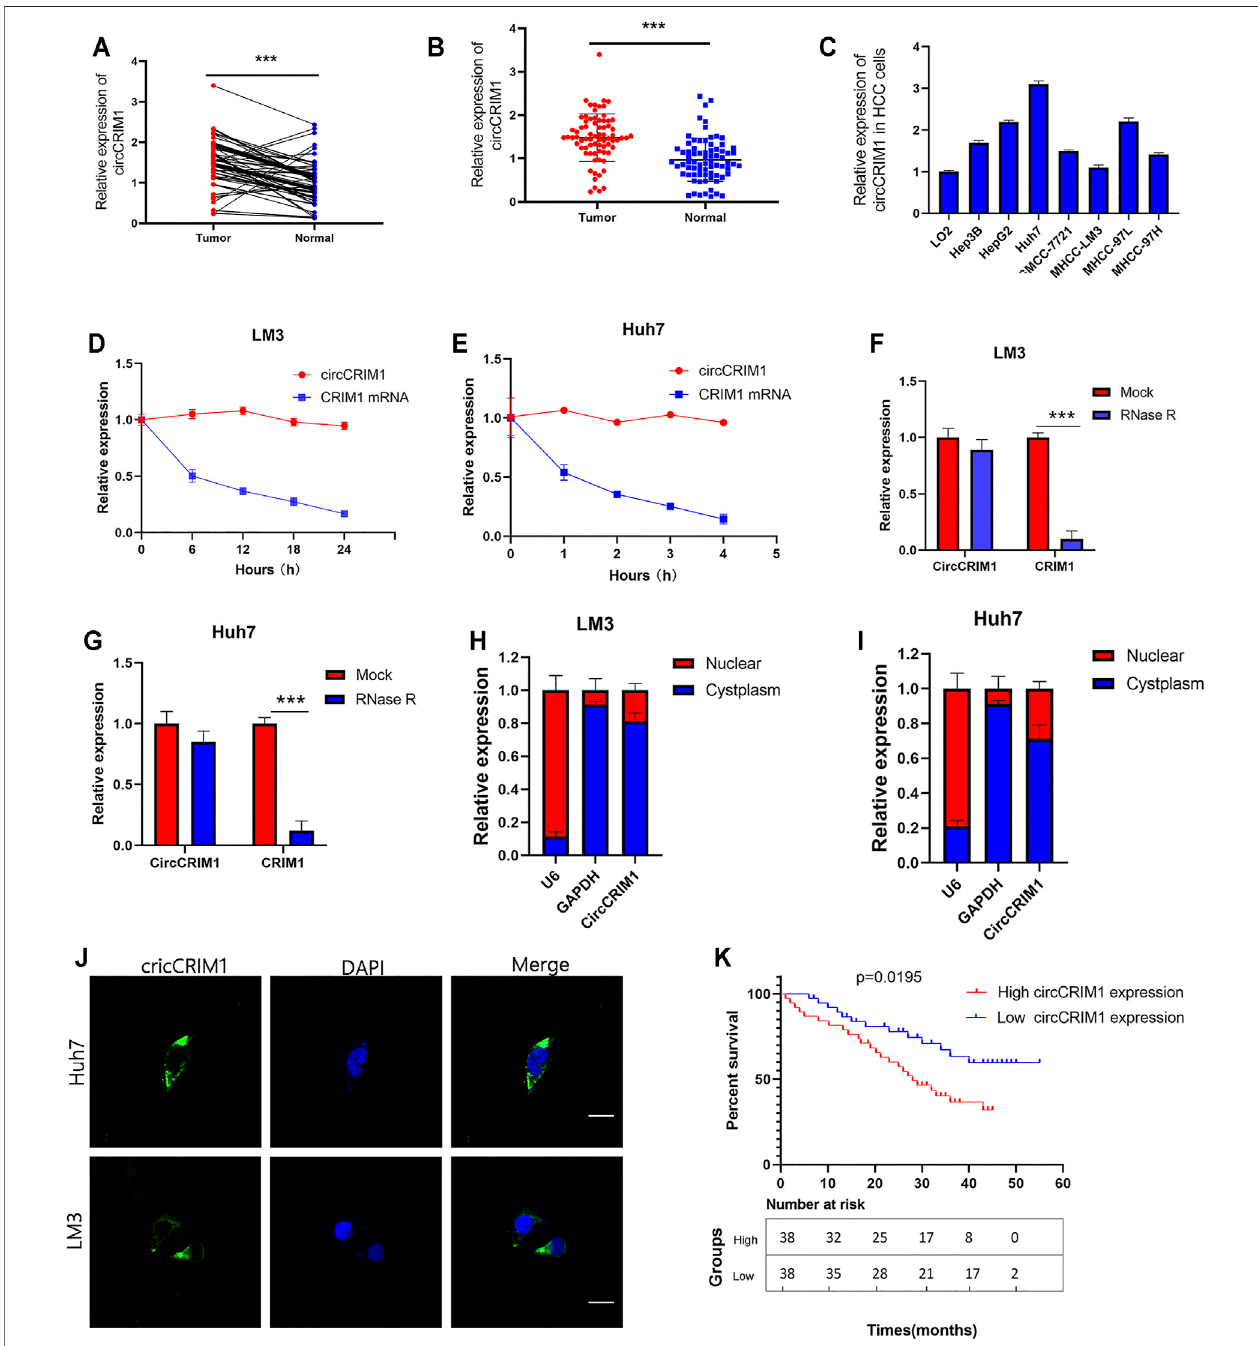
FIGURE 1 | CircCRIM1 is upregulated in HCC cell lines and tissues. (A,B) Relative circCRIM1 expression in HCC tissues (tumor) and adjacent non-tumor tissues (adjacent) was detected by qRT-PCR ( n (cid:2) 76). (C) Relative circCRIM1 expression in HCC cell lines was determined by qRT-PCR. (D,E) Actinomycin D treatment was used to evaluate the stability of circCRIM1 and CRIM1 mRNA in HCC cells. (F,G) CircCRIM1 and linear CRIM1 expression in HCC cells was detected after RNase R treatment and compared with mock treatment. (H,I) Nuclear-cytoplasmic fractionation assay results indicated that cirCRIM1 is primarily localized in the cytoplasm of HCC cells. GADPH and U6 genes were used as cytoplasmic and nuclear controls, respectively. (J) FISH results showed cellular localization of circCRIM1. The circCRIM1 probe was labeled with FAM (green), while nuclei were stained with DAPI (blue).Scale bar (cid:2) 10 μ m. (K) Kaplan-Meier survival analysis showed that HCC patients with high circCRIM1 expression had a lower OS ( p (cid:2) 0.0195) than those with low circCRIM1 expression. All data are presented as the means ± SD of three independent experiments. * p < 0.05, ** p < 0.01, and *** p < 0.001.